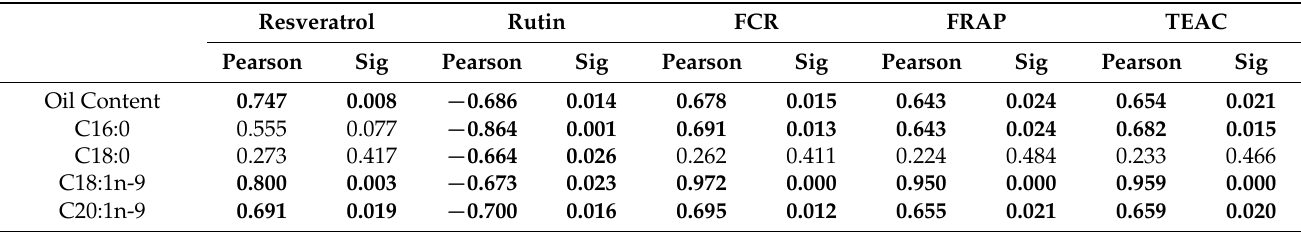
Table 4. Pearson’s correlation coefficients of total antioxidant capacities, oil content, fatty acid and polyphenol concentrations in grape seed pomace samples.